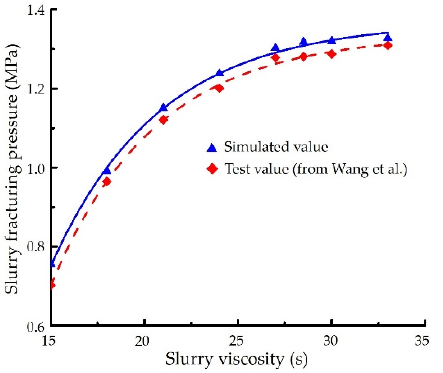
Figure 12. Comparison of simulated values and tests of slurry fracturing pressure under different slurry viscosities [17].